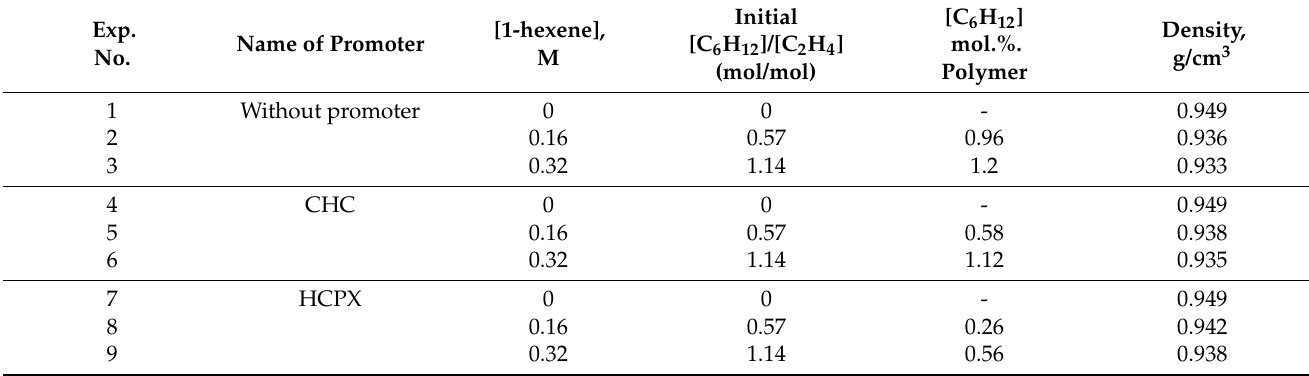
Table 3. The monomer ratio in the initial mixture and in the resulting copolymer.